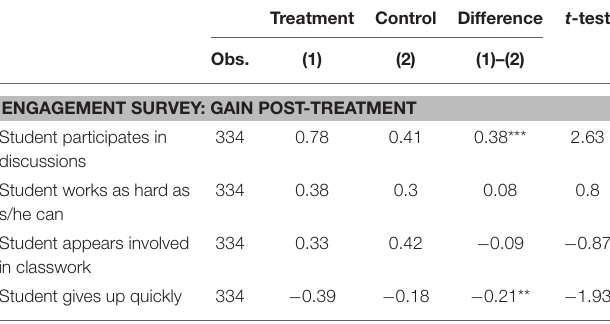
TABLE 7 | Outcomes and baseline traits of students in the randomized controlled trial